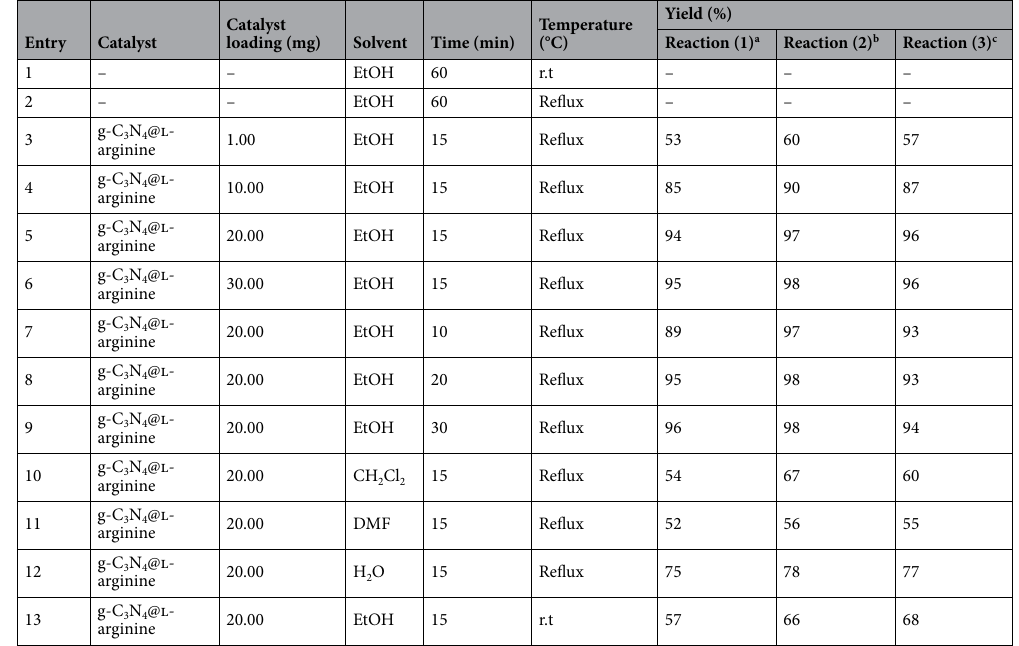
Table 1. Optimization of different parameters for model reactions 1 to 3. a Reaction of 4-chlorobenzaldehyde (1 mmol), ethyl acetoacetate (1 mmol), dimedone (1 mmol), and ammonium acetate (1 mmol) for the synthesis of 1,4-dihydropyridine . b Reaction of 4-chlorobenzaldehyde (1 mmol), dimedone (1 mmol), and malononitrile (1 mmol) for the synthesis of 4H-chromene. c Reaction of 4-chlorobenzaldehyde (1 mmol), isotonic anhydride (1 mmol), and ammonium acetate (1 mmol) for the synthesis of